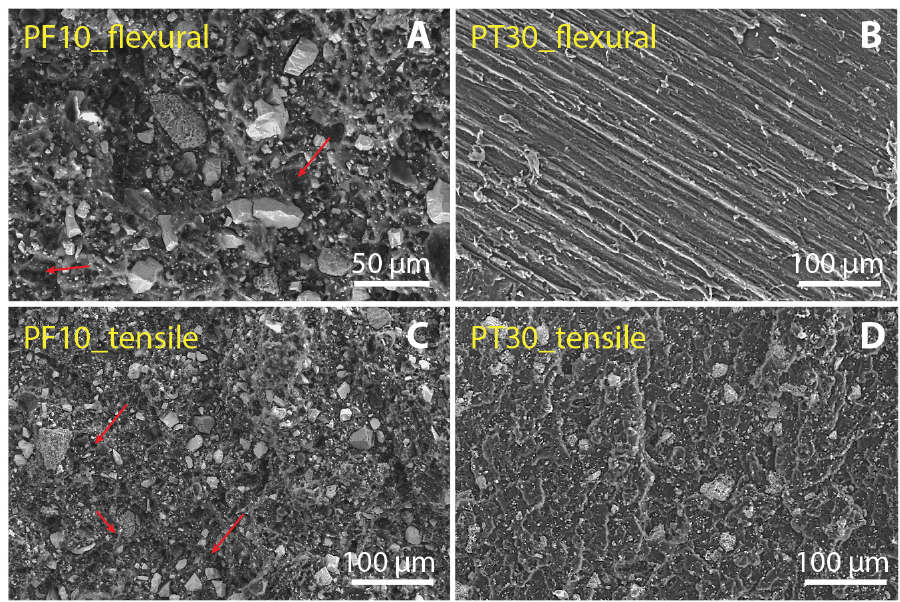
Figure 8. SE images of PF10 ( A , C ) and PT30 ( B , D ) samples showing the fracture surfaces after the flexural ( A , B ) and tensile tests ( C , D ).